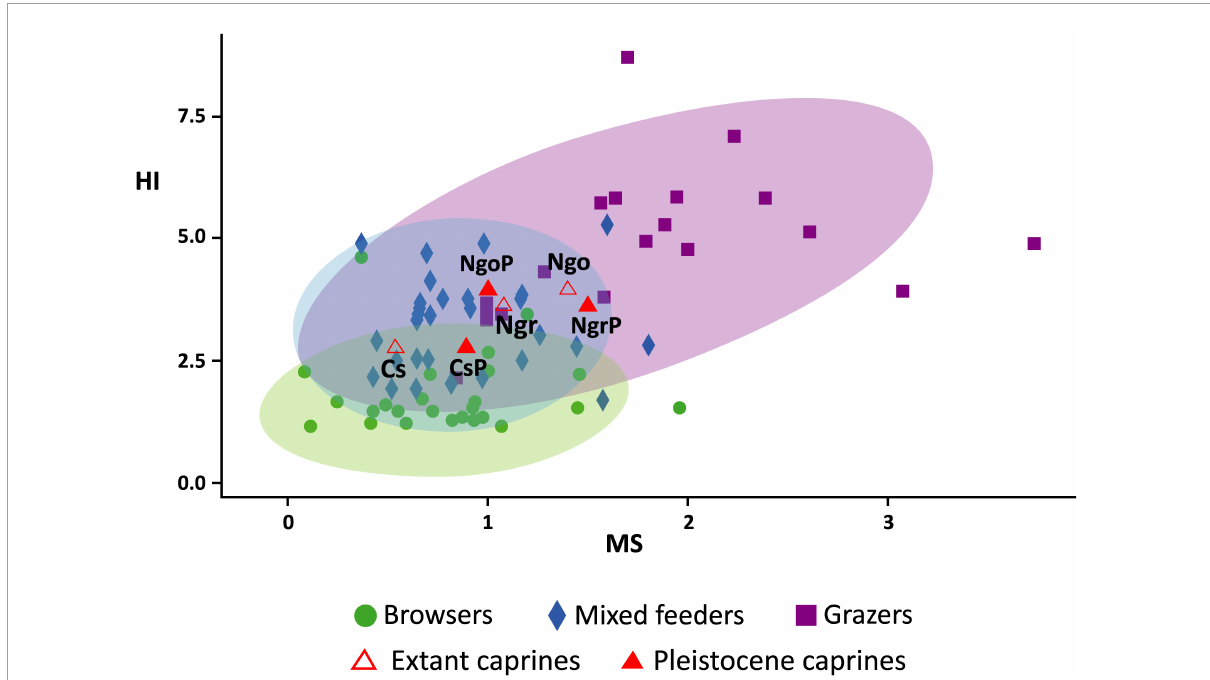
FIGURE5 A bivariate plot of hypsodonty index (HI) against mesowear score (MS). The comparative dataset of extant ungulates is derived from Kaiser et al. (2013). Cs, extant C. sumatraensis , Ngr, extant N. griseus , Ngo, extant N. goral , CsP, Pleistocene C. sumatraensis , NgrP, Pleistocene N. griseus , and NgoP, Pleistocene N. goral .